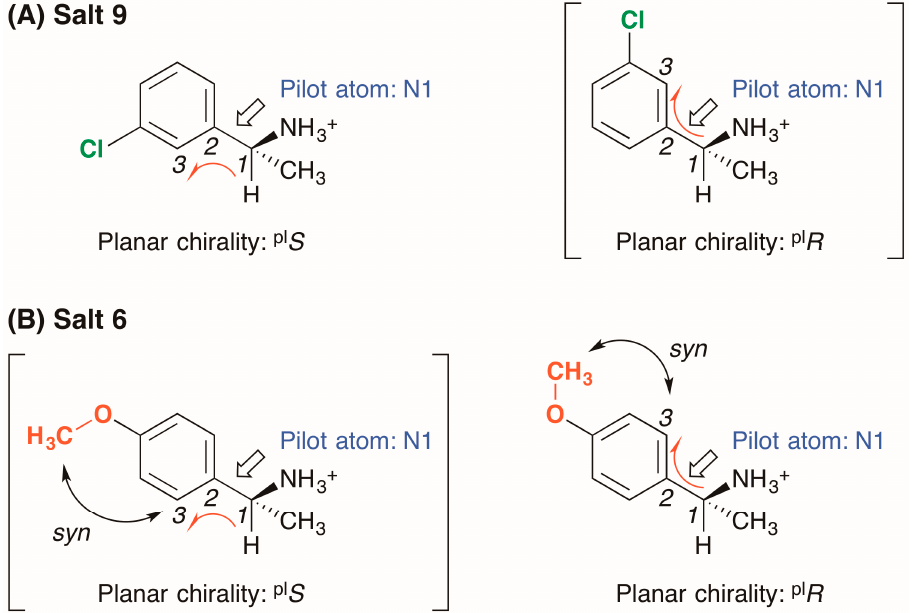
Figure 4. Planar chirality of ( R )-1-arylethylammonium cations in crystalline ( A ) salt 9 and ( B ) salt 6 . The symbols “ pl S ” and “ pl R ” represent left- and right-handed planar chirality, respectively. In salt 6 , higher priority was given to the ortho -carbon atom that is syn to the methoxy group.